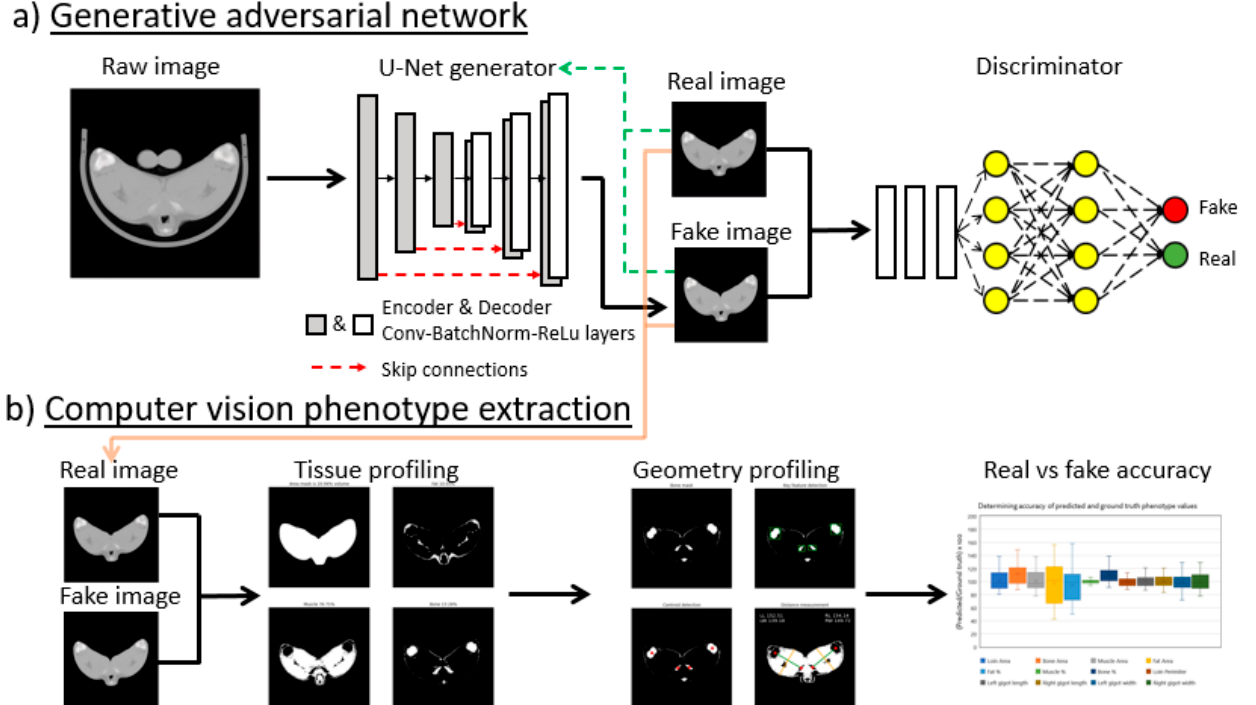
Figure 1. Combined GAN-CV pipeline for phenotype extraction. Neural networks can be trained to perform image-to-image translations such as in ( a ) where a raw ovine CT scan is passed through a generator network, a series of convolution, batch normalisation and ReLu activation function layers, to produce a “fake” image. Skip connections apply regions from the encoded to the encoded images and improve object border definition. By reducing differences between the real and the fake images (green dashes) the autoencoder also learns to better produce fake images independently. A second neural network, the discriminator, then determines if an image is considered real or fake. By pairing the two neural networks to work against each other, an adversarial component emerges, where the generator tries to produces images to fool the discriminator and the discriminator tries to determine if these images are real or not. Phenotype extraction is performed on both real and fake images ( b ) to determine tissue composition and shape before being compared to confirm